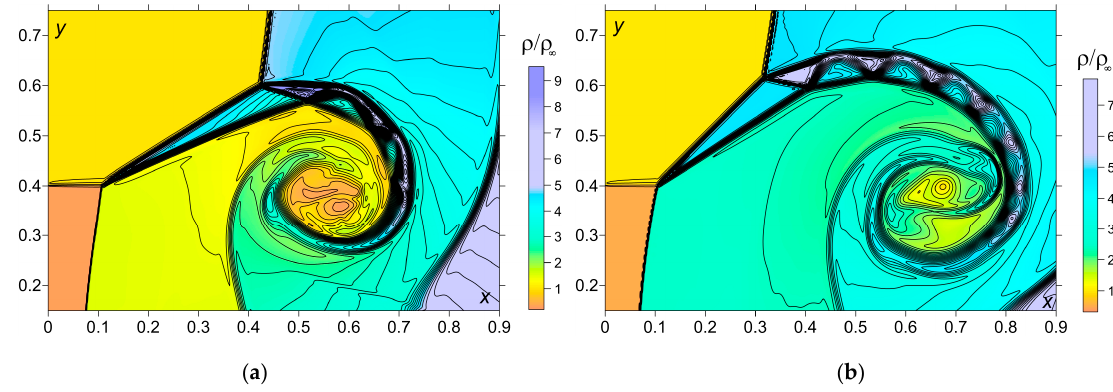
Figure 13. Triple-shock configurations together with vortex-contact structures. Density (colors and isochors), M = 9, γ = 1.3, enlarged: ( a ) α ρ = 0. 3, t = 0.2; ( b ) α ρ = 0. 5, t = 0.3.